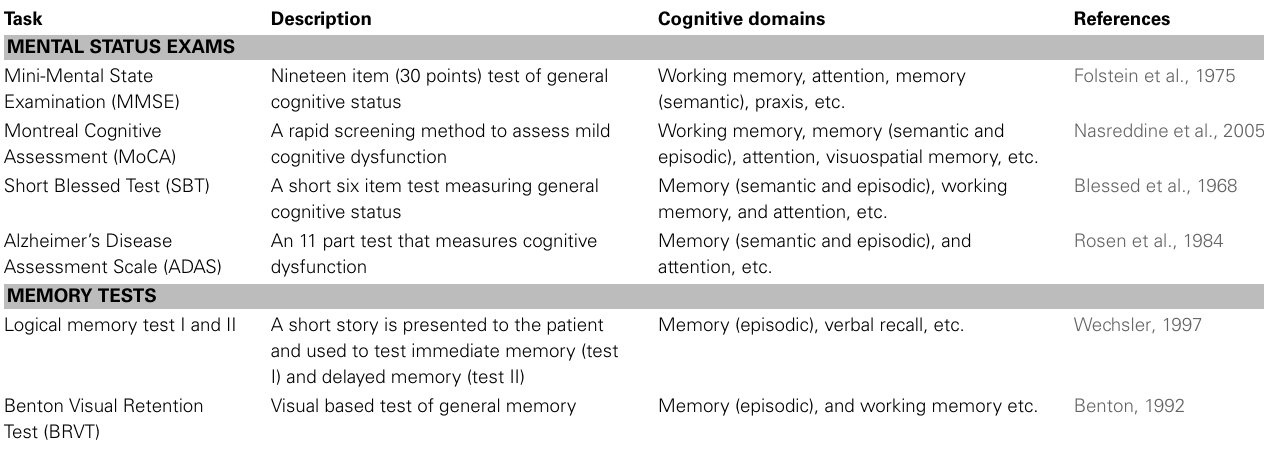
Table 1 | Common neuropsychological assessment tasks seen